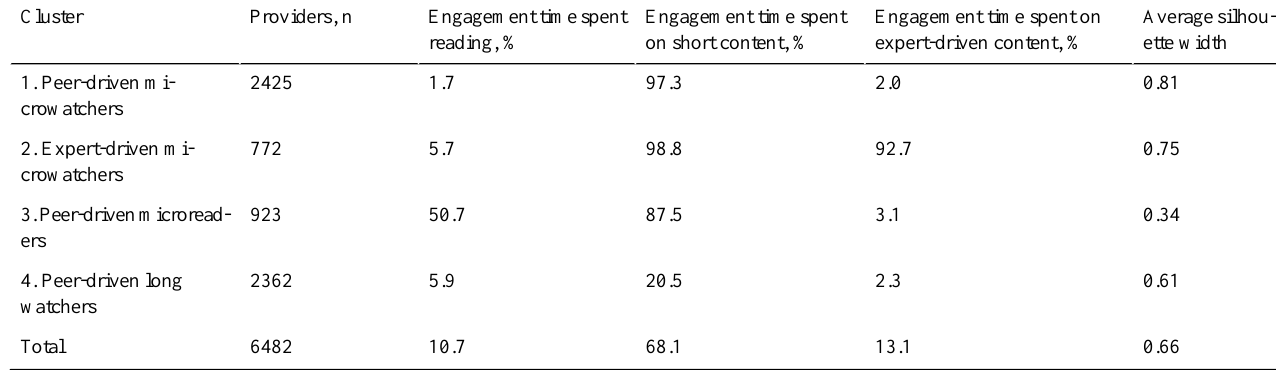
Table 4. Clusters and their